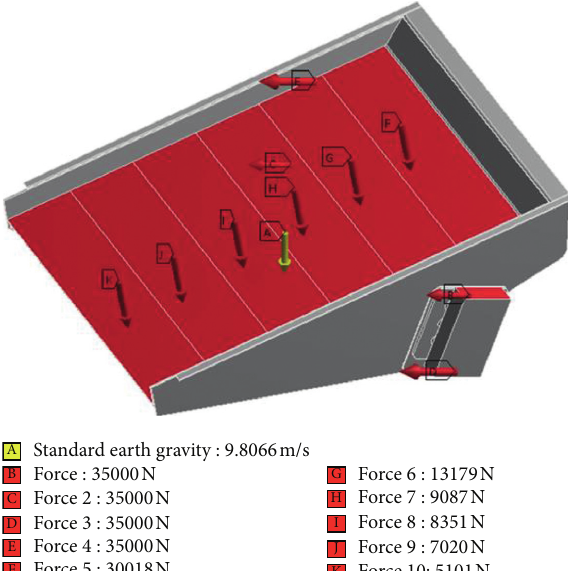
Figure 8: Boundary condition setting.